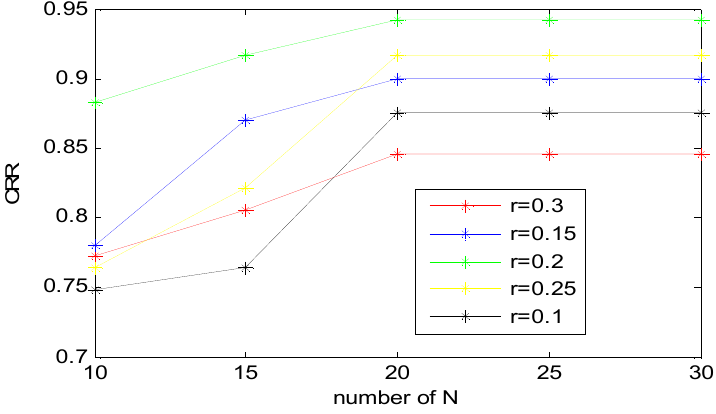
Figure 11. Performance of the heart sound identification system based on EEMD’s N and r